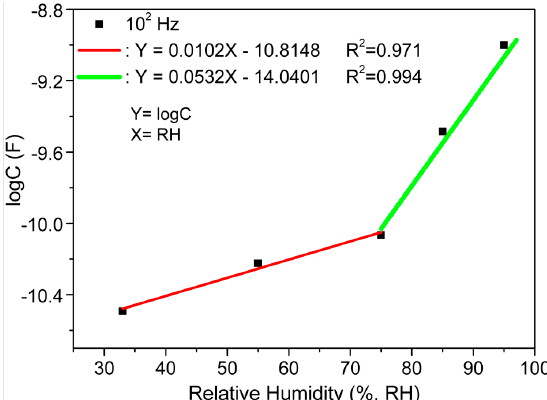
Figure 9. The transformed response curves of logarithmic capacitance (logC) vs. RH of CMFTO electro-ceramic based capacitive sensor. Note: first linear transformation curve (red-line) is well fitted by logC = 0.0102RH − 10.8148 in the RH range from 33% to 75% and the second linear transformation curve (green-line) is well fitted by the formula logC = 0.0532RH − 14.0401 at the higher humidity range (>75% RH). Here, regression, R 2 represents a best fit of the curves to improve linearity.